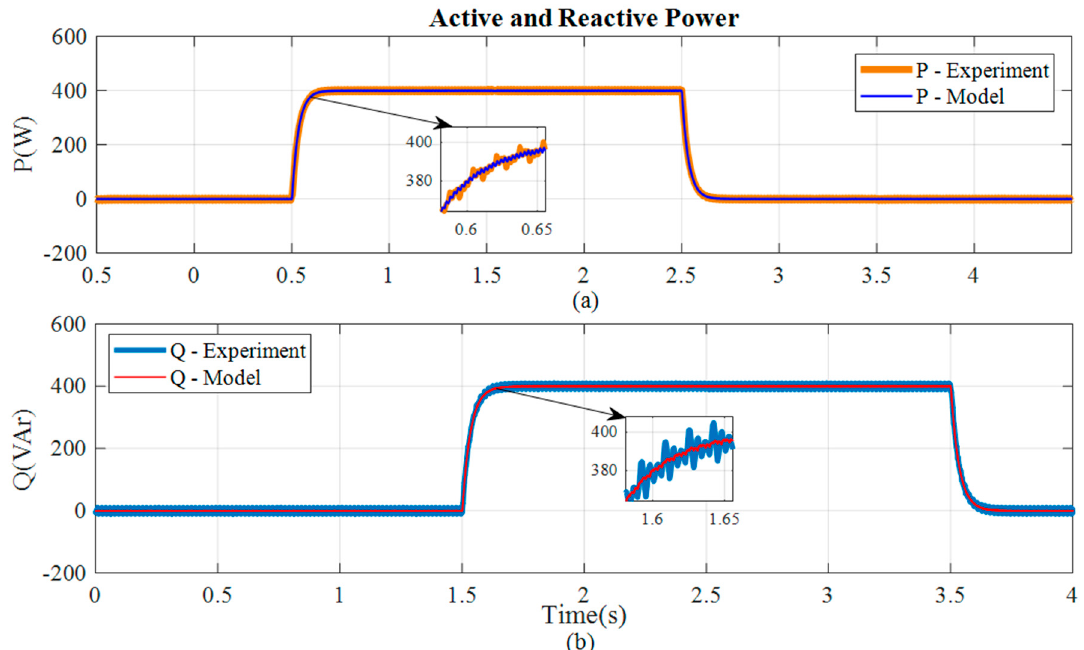
Figure 20. Comparison between the experimental and mathematical values for the active and reactive power under a step reference of 400 W and 400 Var. ( a ) Active power; ( b ) reactive